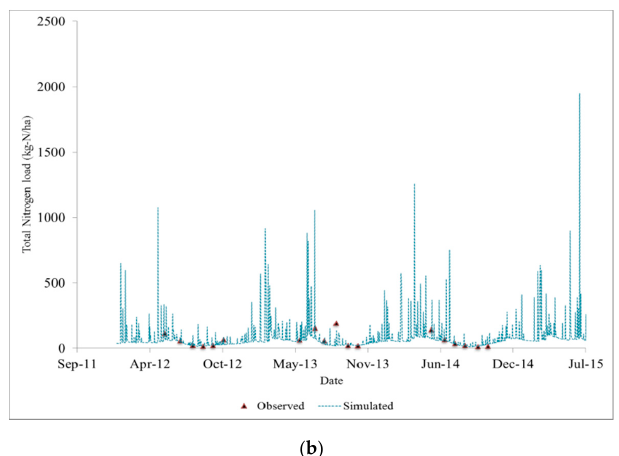
Figure 4. Figure 4 shows Total Nitrogen simulation from the SWAT model using OWTS simulations: ( a ) SWAT calibration from December 2006 to December 2011; ( b ) SWAT validation from September 2011 to July 2015. Table 4. Total nitrogen calibration parameters.